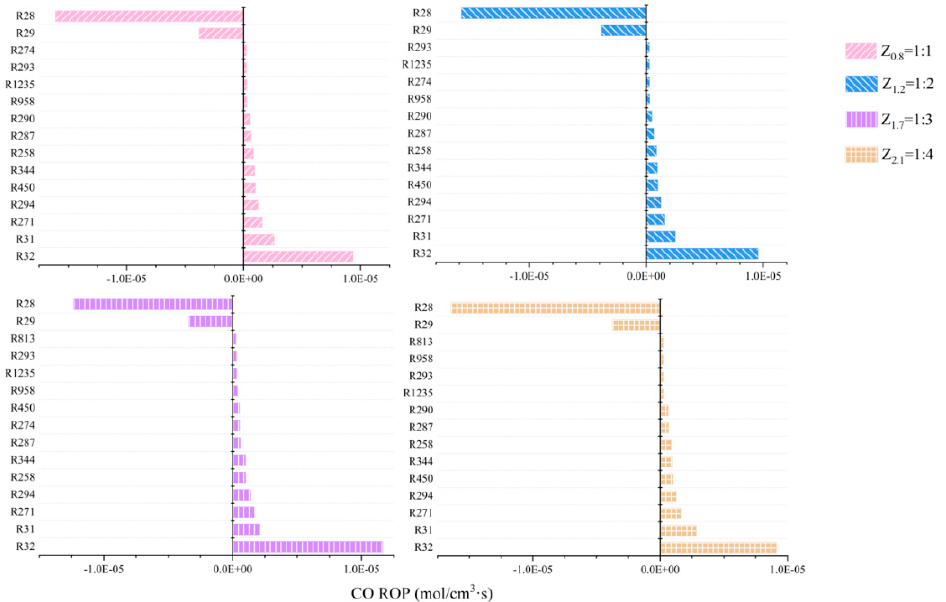
Figure 16. Comprehensive comparison of CO ROP of air–light hydrocarbon mixing gas at the maximum mixing degree for equivalence ratios of n -pentane.